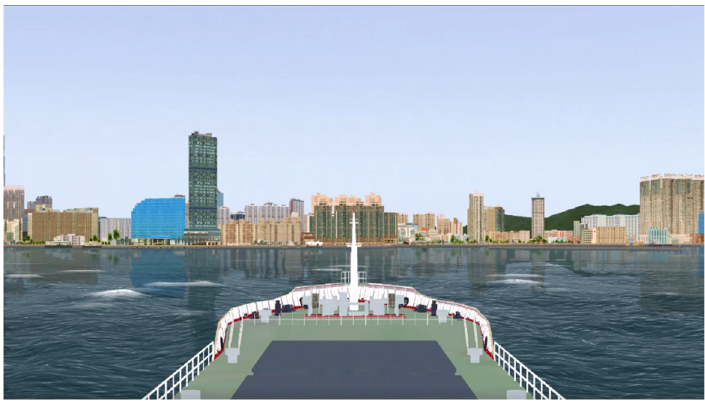
Figure 2. Interior view of marine simulator.